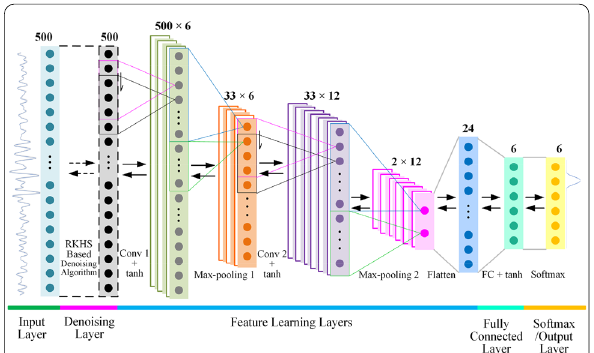
Figure 6 CNN based structure applied to the experiment